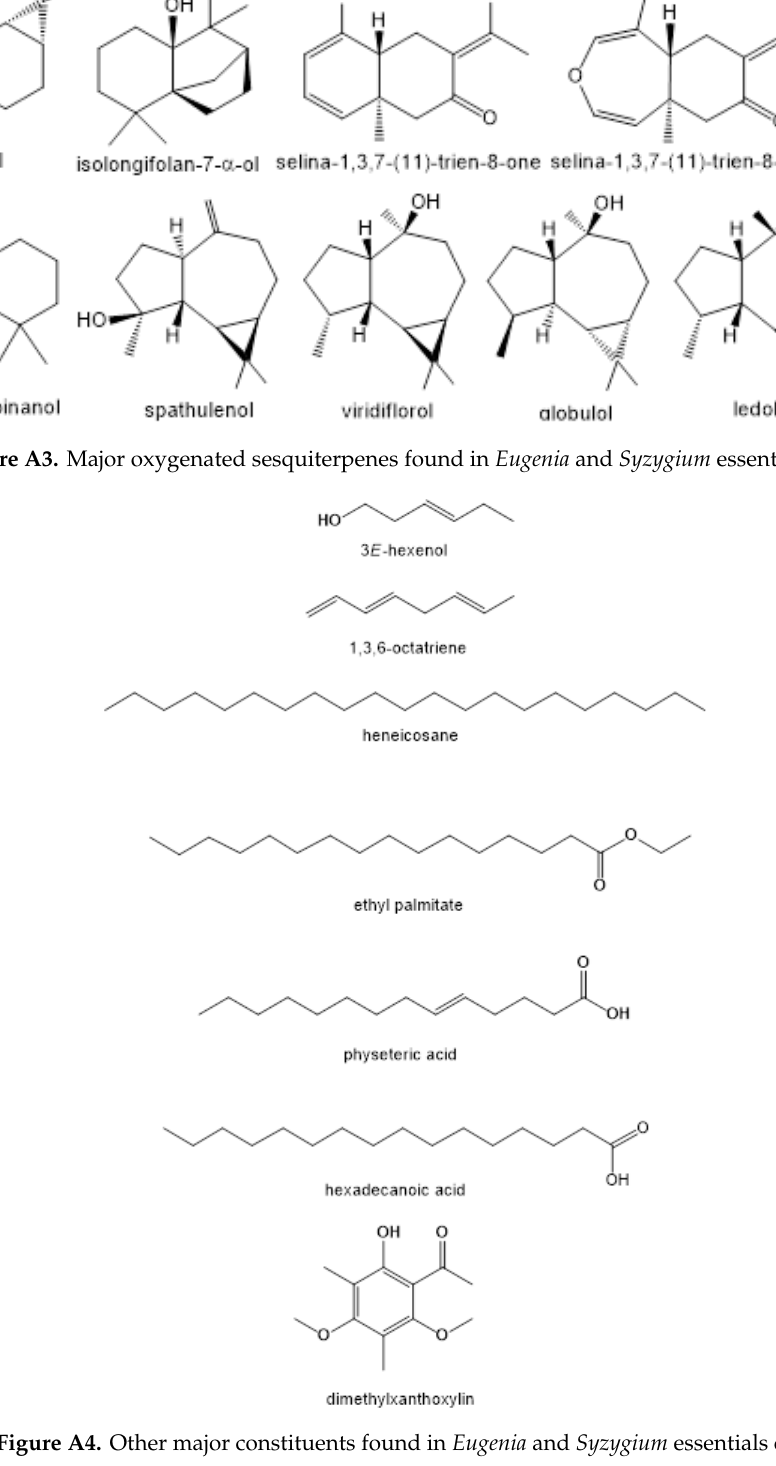
Figure A4. Other major constituents found in Eugenia and Syzygium essentials oils.